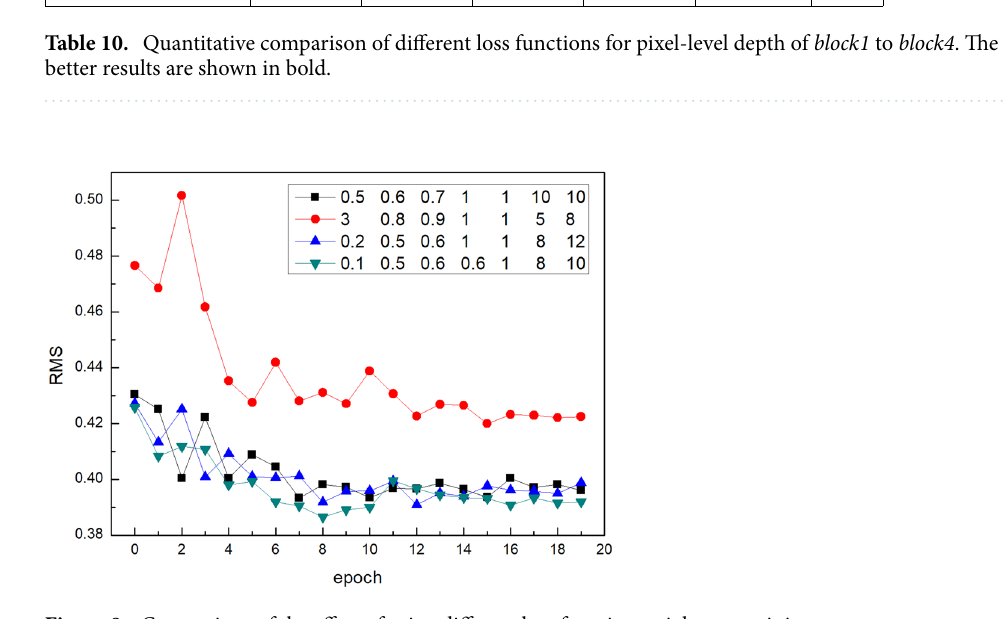
Figure 8. Comparison of the effect of using different loss function weights on